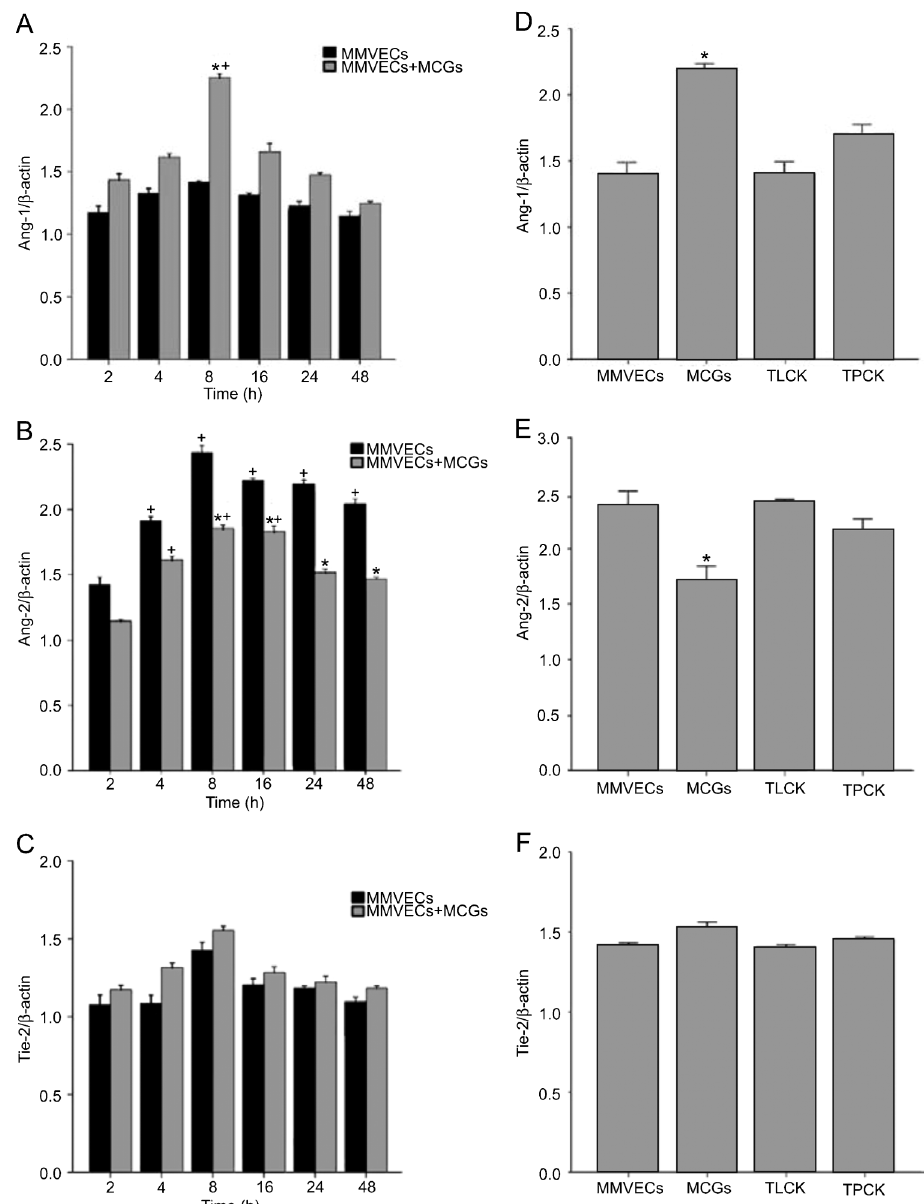
Figure 3. Ang-1, Ang-2 and Tie-2 mRNA expression in MMVECs. A , Ang-1 increased significantly in MMVECs with MCGs at 8 h. B , Ang-2 decreased significantly in MMVEC with MCGs compared to MMVECs from 8 h. C , Tie-2 mRNA was not affected by MCGs. D - F , Both TLCK and TPCK abolished the effects of MCGs on Ang-1 and Ang-2 mRNA expression, without affecting Tie-2 mRNA expression. Ang: angiopoietin; MMVECs: myocardial microvascular endothelial cells; MCGs: mast cell granules; TLCK: N-tosyl-L-lysine chloromethyl ketone; TPCK: N -tosyl-L-phenylalanyl-chloromethyl ketone. *P , 0.05 vs MMVECs, + P , 0.05 vs 2 h (Student-Newman- Keuls